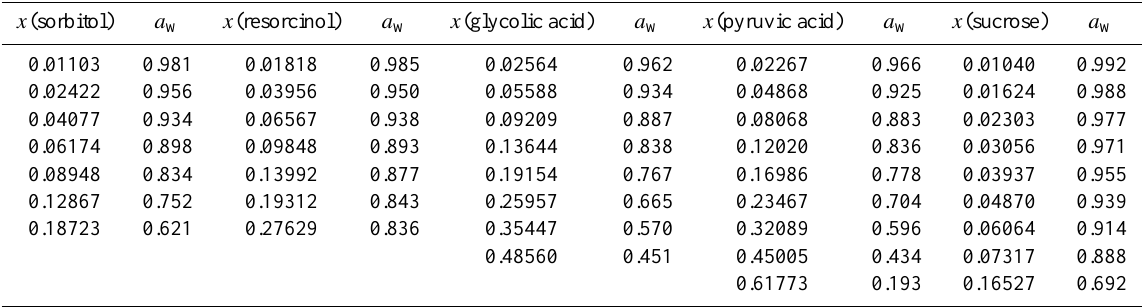
Table 3. Bulk water activity (a w ) measurements ∗ at 298.15K of different aqueous organic solutions. Solution compositions are expressed in mole fraction x